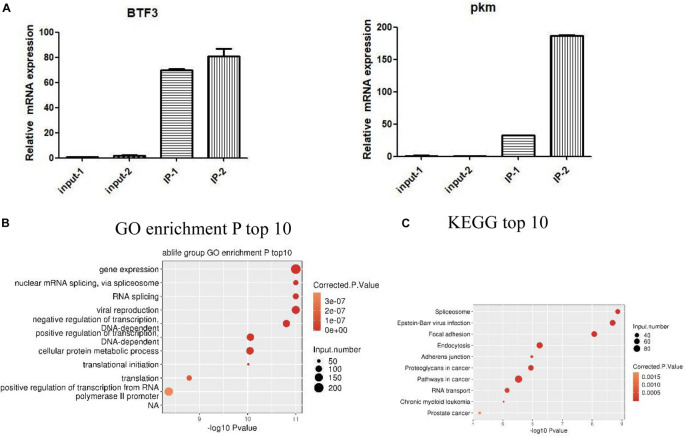
IGF2BP3-bound genes are distributed in various pathways. (A) RIP-qPCR validation of IGF2BP3-bound genes. (B,C) The top 10 representative pathways of IGF2BP3-bound genes in GO database and KEGG database.